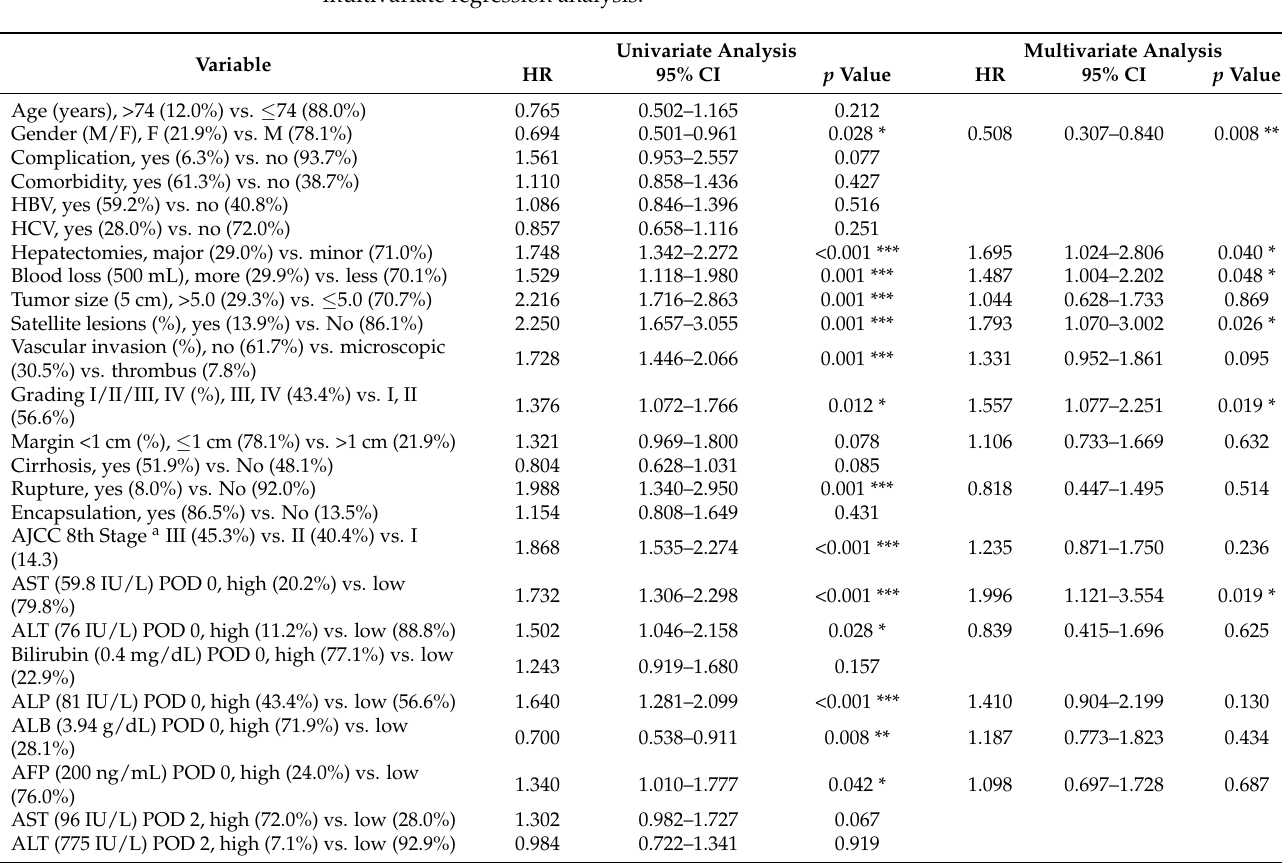
Table 2. Clinicopathologic data and sequential change in 525 HCC patients in univariate and multivariate regression